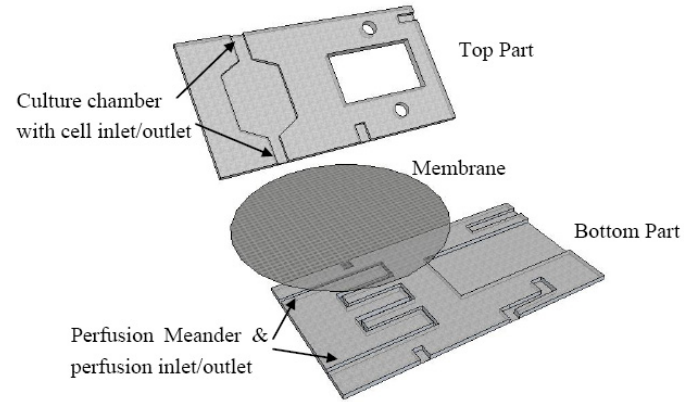
Figure 1. Exploded view of the FISHprep device top and bottom part. A polycarbonate membrane is sandwiched between the two parts to form the barrier between the culture chamber and perfusion